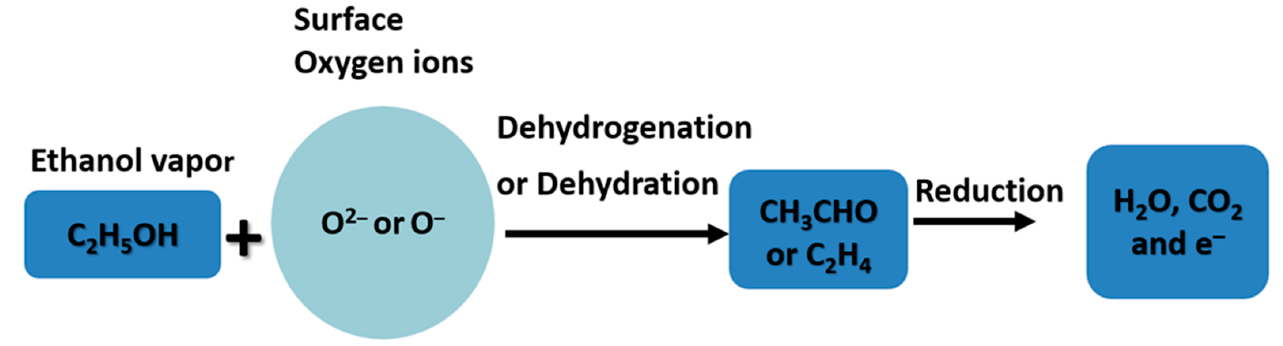
Figure 8. Gas response mechanism of the ZnO thin film based on ethanol vapor.